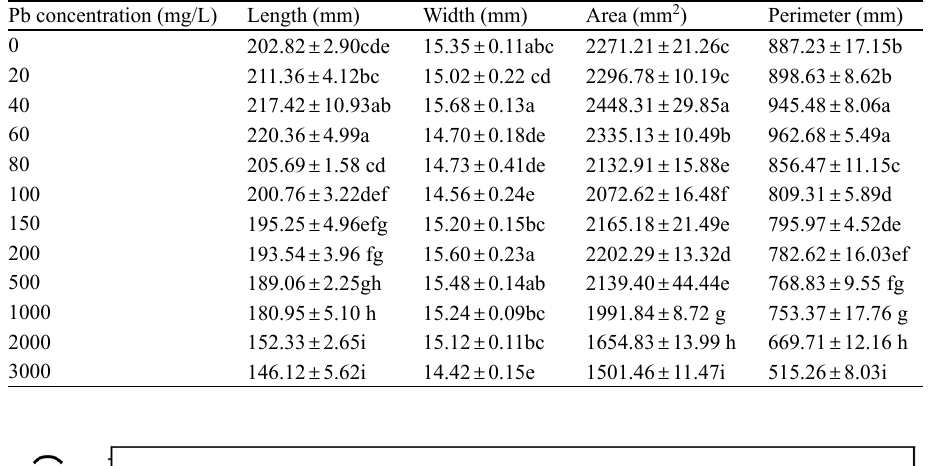
Fig. 6 Inhibition rate of differ -